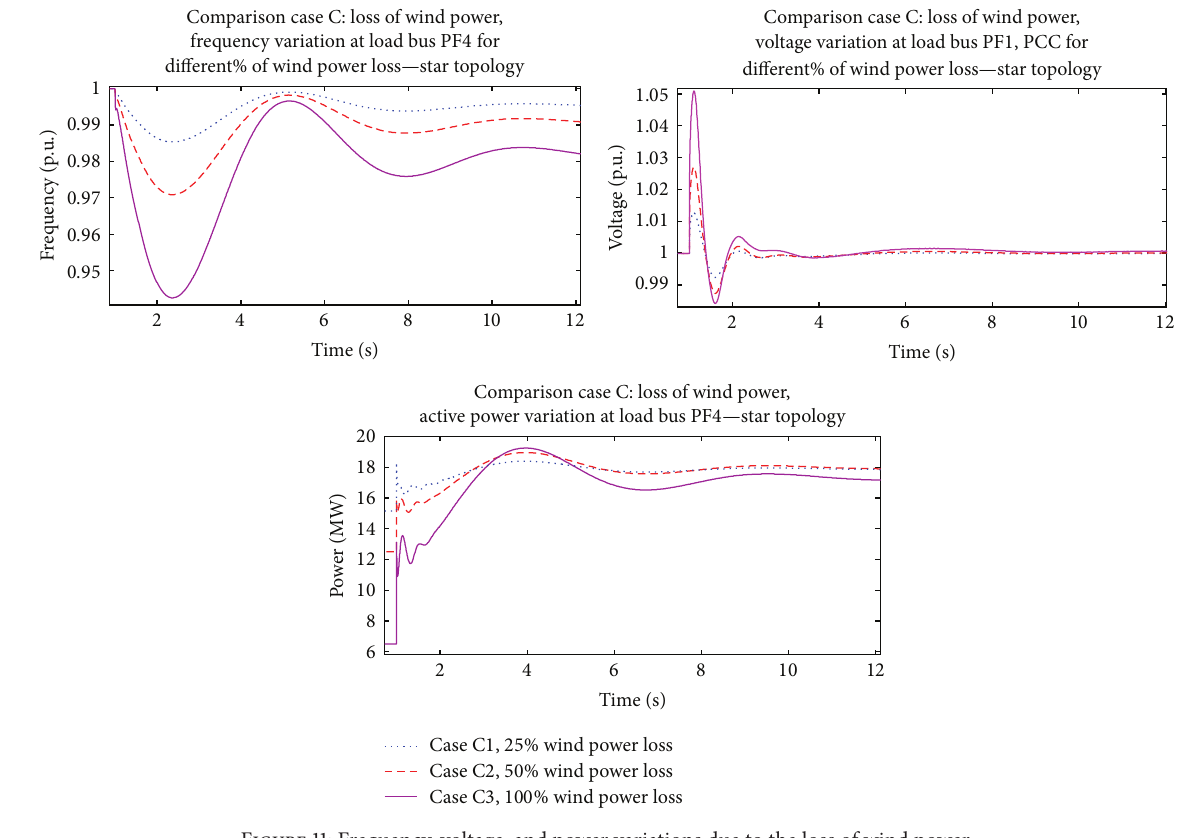
Comparison case C: loss of wind power, active power variation at load bus PF —star